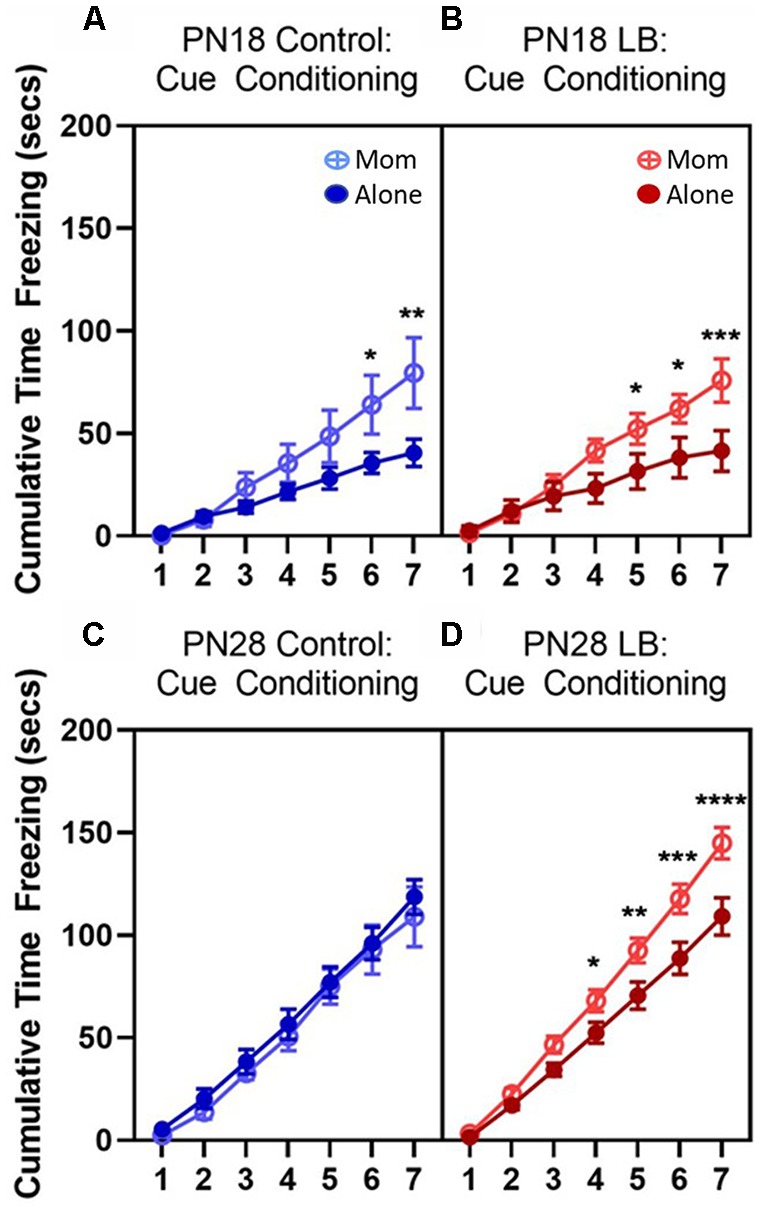
Odor-shock cue conditioning increases freezing to odor during training. Total cumulative (seconds) freezing (±SEM) during paired odor-shock cue conditioning at (A,B) PN18 (Control: Alone n = 8; Mom n = 8; LB: Alone n = 8; Mom n = 8) and (C,D) PN28 (Control: Alone n = 9; Mom n = 8; LB: Alone n = 14; Mom n = 15). Cue conditioning increased freezing at both ages in both control and low bedding (LB) rearing conditions however increased freezing was observed in animals conditioned with the mom (except in PN28 Control group) relative to animals conditioned alone. Open circle = conditioned with the mom; filled circles = conditioned alone; blue = controls; red = LB. *p < 0.05, **p < 0.01, ***p < 0.001, ****p < 0.0001.